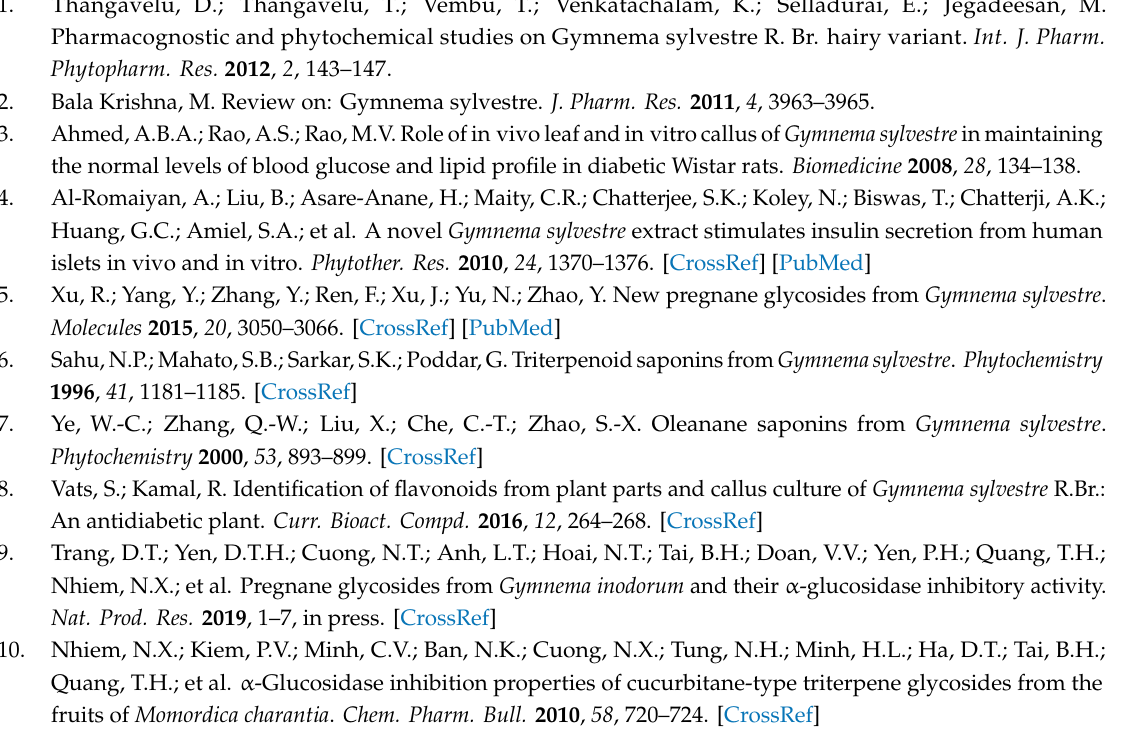
Supplementary Materials: Figure S1: The chemical structures of compounds 6 – 9 ; Figure S2: HR-ESI-MS of compound 1 , Figure S3: 1 H-NMR spectrum of compound 1 , Figure S4: 13 C-NMR spectrum of compound 1 , Figure S5: DEPT135 spectrum of compound 1 , Figure S6: HSQC spectrum of compound 1 , Figure S7: HMBC spectrum of compound 1 , Figure S8: COSY spectrum of compound 1 , Figure S9: ROESY spectrum of compound 1 , Figure S10: HR-ESI-MS of compound 2 , Figure S11: 1 H-NMR spectrum of compound 2 , Figure S12: 13 C-NMR spectrum of compound 2 , Figure S13: DEPT135 spectrum of compound 2 , Figure S14: HSQC spectrum of compound 2 , Figure S15: HMBC spectrum of compound 2 , Figure S16: COSY spectrum of compound 2 , Figure S17: ROESY spectrum of compound 2 , Figure S18: HR-ESI-MS of compound 3 , Figure S19: 1 H-NMR spectrum of compound 3 , Figure S20: 13 C-NMR spectrum of compound 3 , Figure S21: HSQC spectrum of compound 3 , Figure S22: HMBC spectrum of compound 3 , Figure S23: COSY spectrum of compound 3 , Figure S24: ROESY spectrum of compound 3 , Figure S25: HR-ESI-MS of compound 4 , Figure S26: 1 H-NMR spectrum of compound 4 , Figure S27: 13 C-NMR spectrum of compound 4 , Figure S28: DEPT135 spectrum of compound 4 , Figure S29: HSQC spectrum of compound 4 , Figure S30: HMBC spectrum of compound 4 , Figure S31: COSY spectrum of compound 4 , Figure S32: ROESY spectrum of compound 4 , Figure S33: HR-ESI-MS of compound 5 , Figure S34: 1 H-NMR spectrum of compound 5 , Figure S35: 13 C-NMR spectrum of compound 5 , Figure S36: DEPT135 spectrum of compound 5 , Figure S37: HSQC spectrum of compound 5 ; Figure S38: HMBC spectrum of compound 5 ; Figure S39: COSY spectrum of compound 5 ; Figure S40: 1 H-NMR spectrum of compound 6 ; Figure S41: 13 C-NMR spectrum of compound 6 ; Figure S42: HSQC spectrum of compound 6 ; Figure S43: 1 H-NMR spectrum of compound 7 ; Figure S44: 13 C-NMR spectrum of compound 7 ; Figure S45: HSQC spectrum of compound 7 ; Figure S46: 1 H-NMR spectrum of compound 8 ; Figure S47: 13 C-NMR spectrum of compound 8 ; Figure S48: HSQC spectrum of compound 8 ; Figure S49: 1 H-NMR spectrum of compound 9 ; Figure S50: 13 C-NMR spectrum of compound 9 ; Figure S51: HSQC spectrum of compound 9